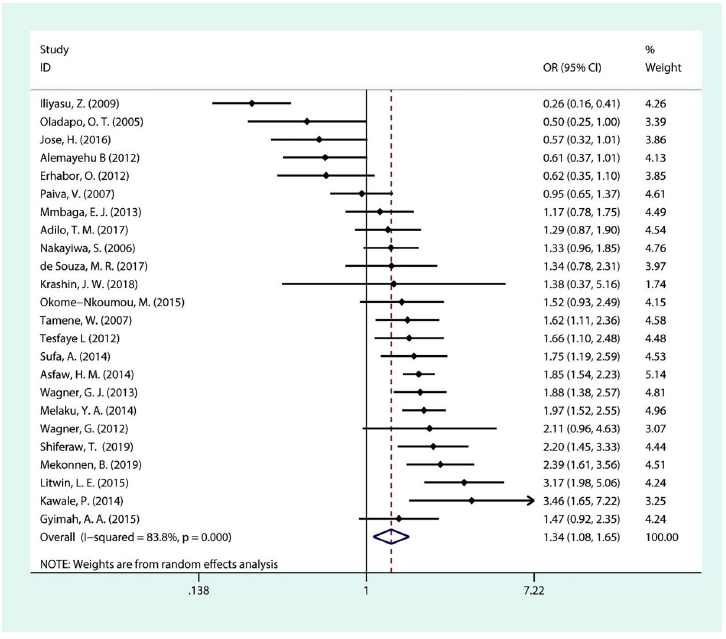
Fig 6. Forest plot of pooled OR for fertility desire in PLHIV (currently married vs unmarried).